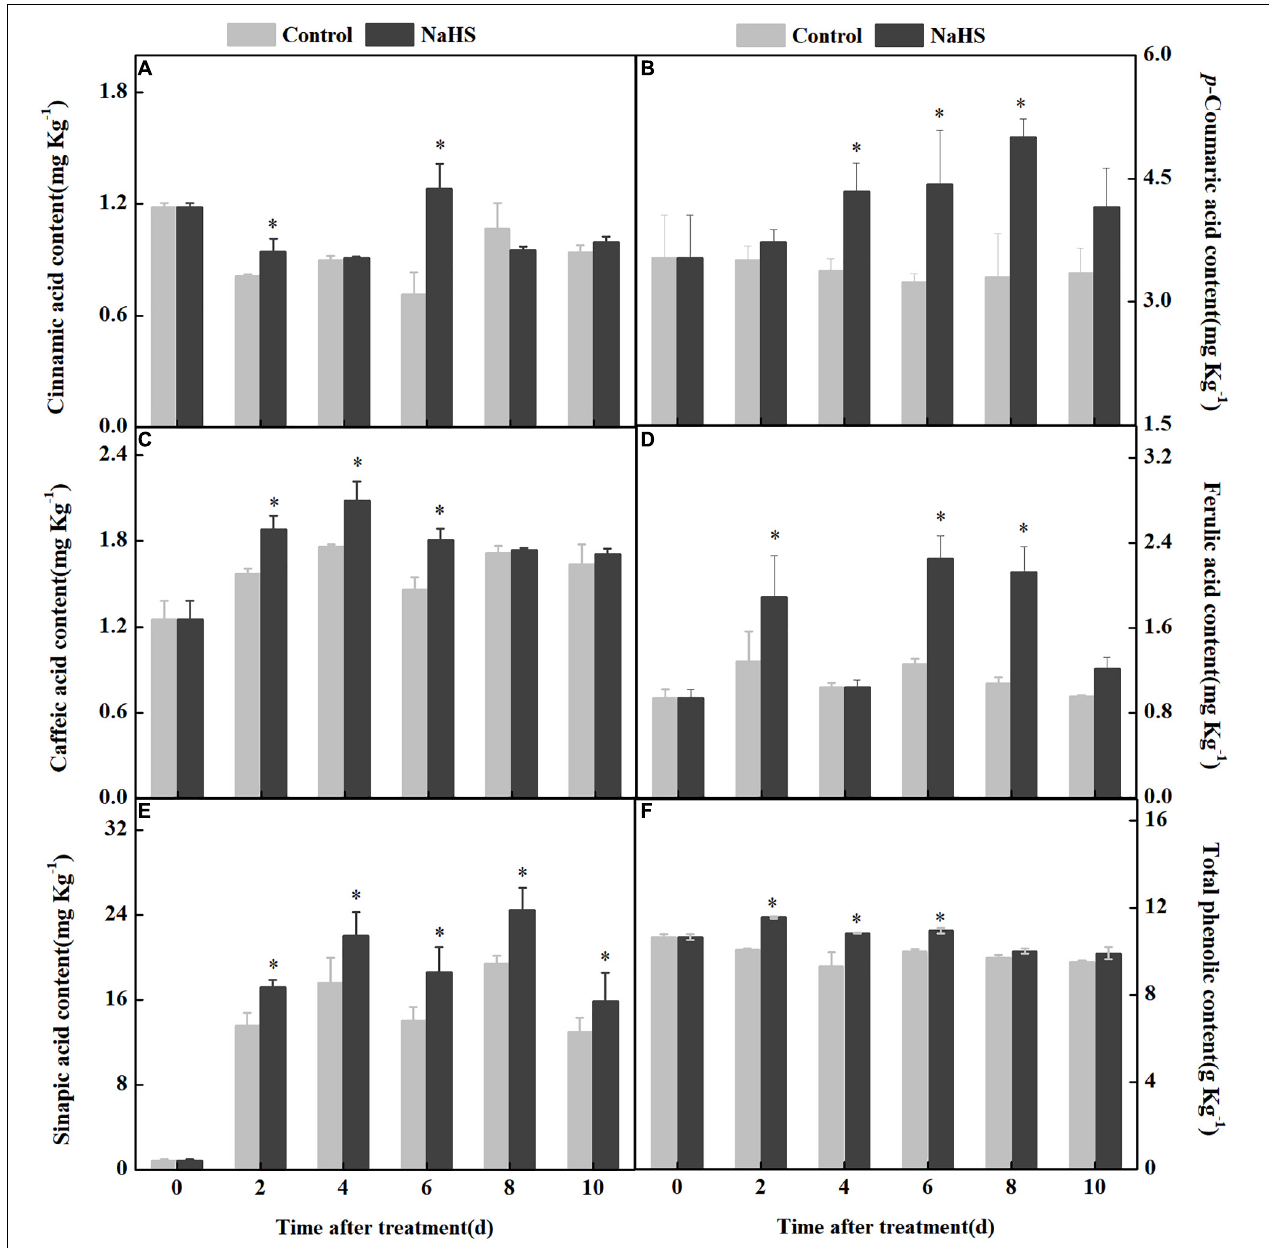
FIGURE 4 | Changes in the content of five phenolic acids and total phenolic compounds in apples after NaHS treatment. Cinnamic acid (A) , p -coumaric acid (B) , caffeic acid (C) , ferulic acid (D) , sinapic acid (E) , and total phenolic compounds (F) . The light gray and black bars represent the control and NaHS treatments, respectively. The bars represent the standard error of the mean ( ± SE). ∗ Significant differences at P <